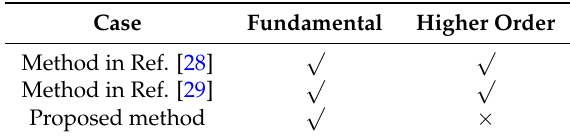
Table 3. Composition of harmonics.